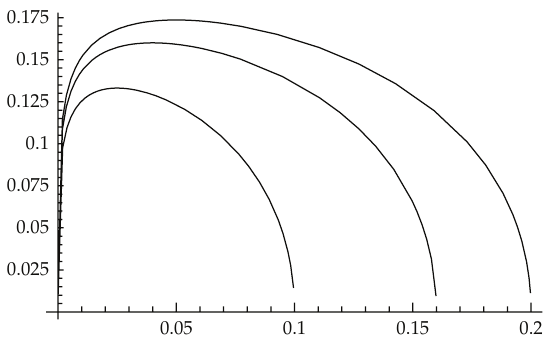
Figure 1: Graphic of g when c 2 (cid:6) 1 and c 1 (cid:6) a is 5, 6 . 25, and 10, respectively. We see that g has two monotone